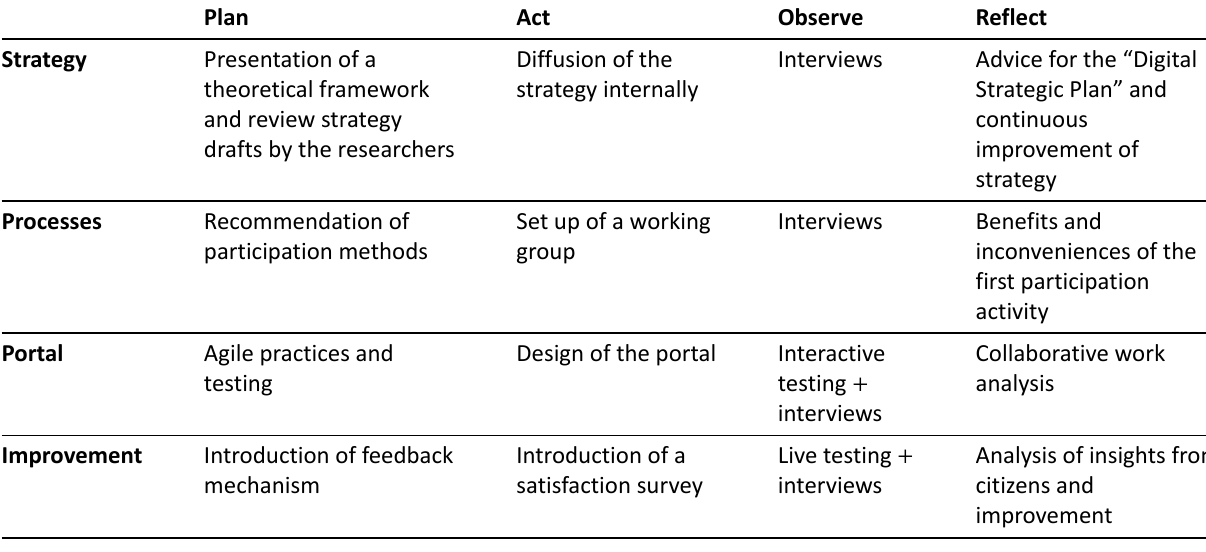
Table 2. Action research: study